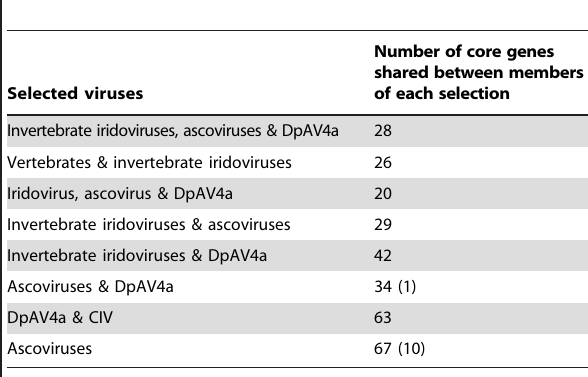
Table 2. Cores genes shared between and among viruses of the families Iridoviridae , Ascoviridae and DpAV4a.